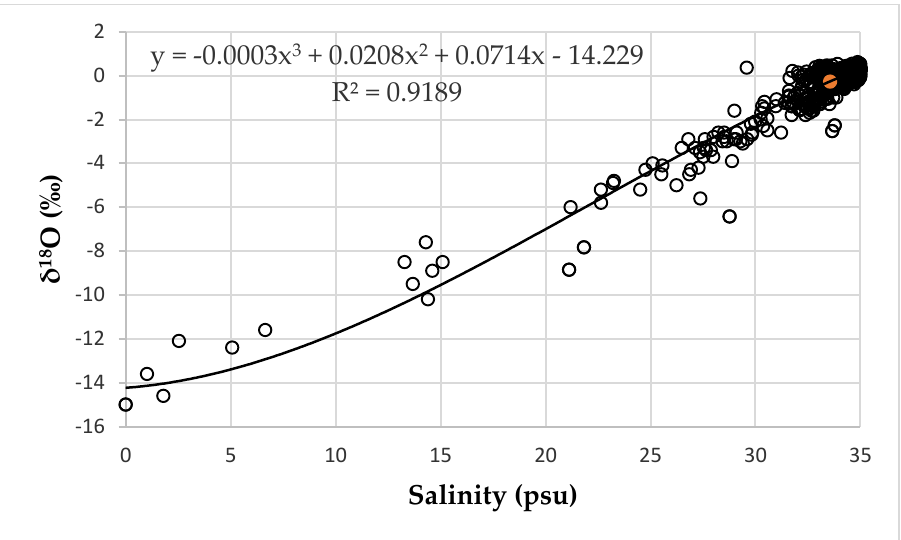
Figure 4. Relationship equation between salinity (psu) and δ 18 O ( ‰) in the Barents Sea .